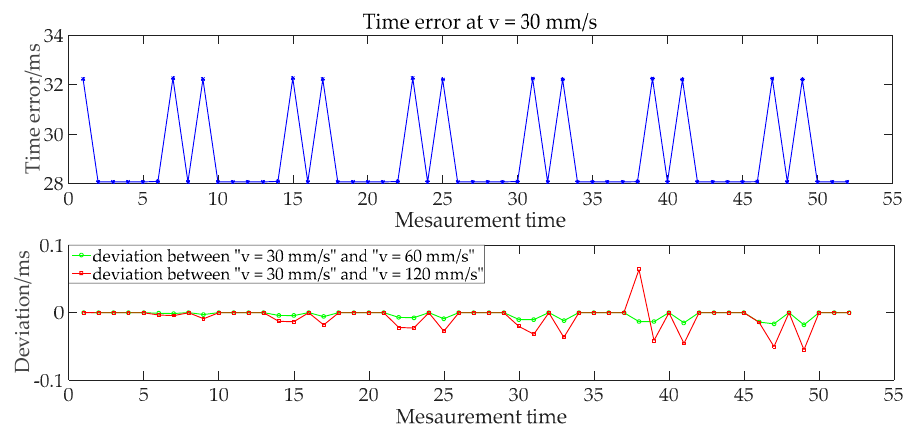
Figure 4. Dynamic time error in the four-transmitter network.